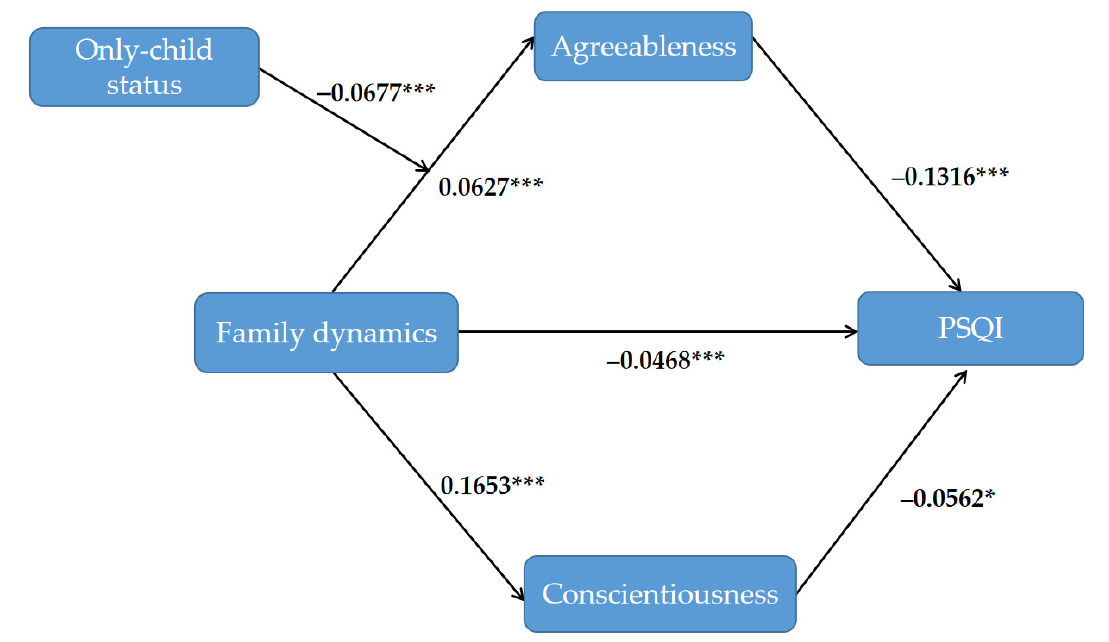
Figure 2. The verified model of the moderated mediation effects between family dynamics and PSQI (N = 963). The study found that conscientiousness and agreeableness of big five personality traits mediated the association between family dynamics and sleep quality. Only-child status significantly moderated the impact of family dynamics on agreeableness.* p < 0.05, *** p < 0.001.